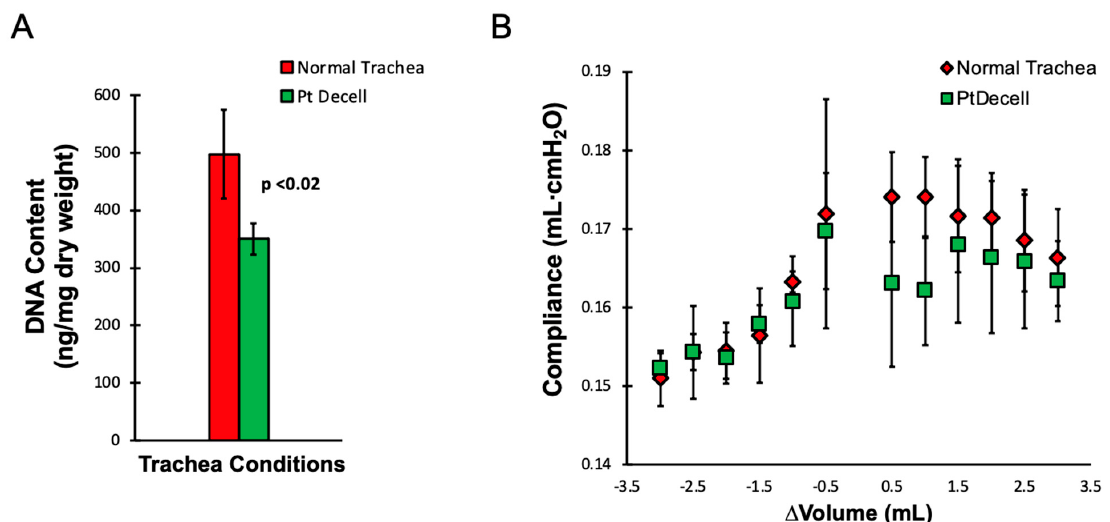
Figure 7. DNA quantification and mechanical analysis. ( A ) DNA quantification between the normal and partly decellularized tracheas showed a significant difference ( p < 0.05), suggesting that the bulk of DNA and antigenic burden was in the luminal compartment. ( B ) A comparison of tracheal compliance between normal and decellularized conditions showed no difference ( p > 0.05) across a range of inflated and aspirated volumes. This demonstrates that the partly decellularized tracheas retained their biomechanical